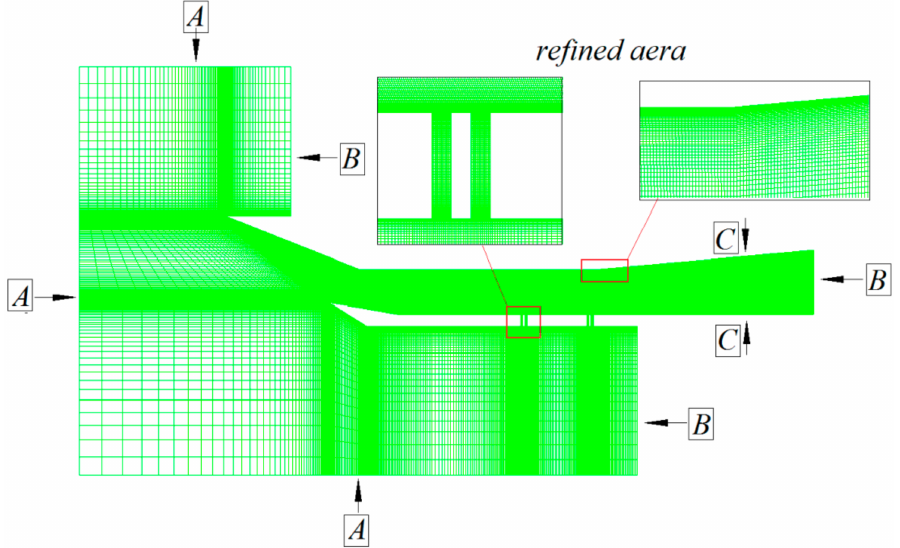
Figure 4. Computing domain and